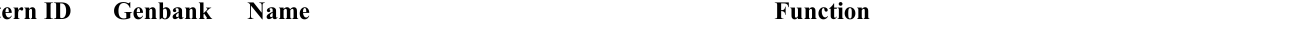
IC values for acetoside of 10 50